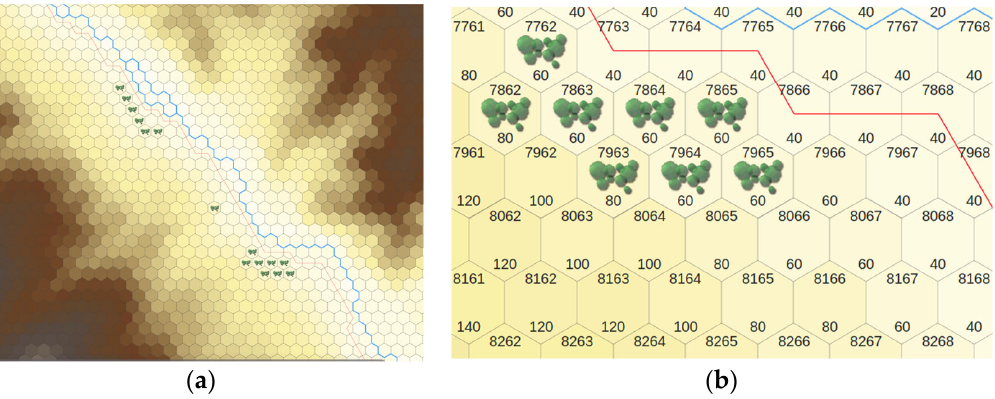
Figure 9. The wargame experimental environment. ( a ) A part of the wargame map; ( b ) The specific parameters in the hexagonal grid, including elevation and coordinates.